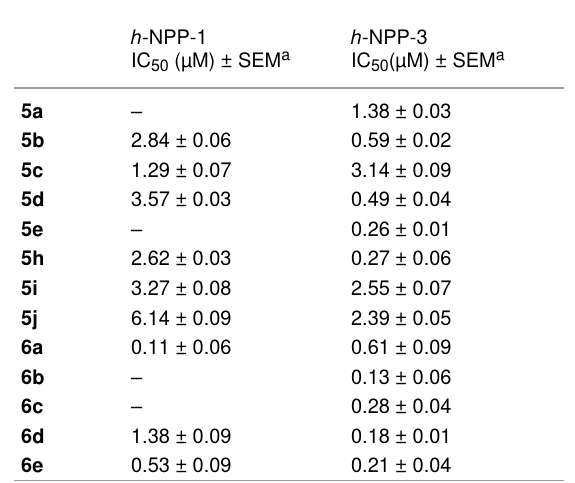
Table 3: Biological activity of 5 and 6